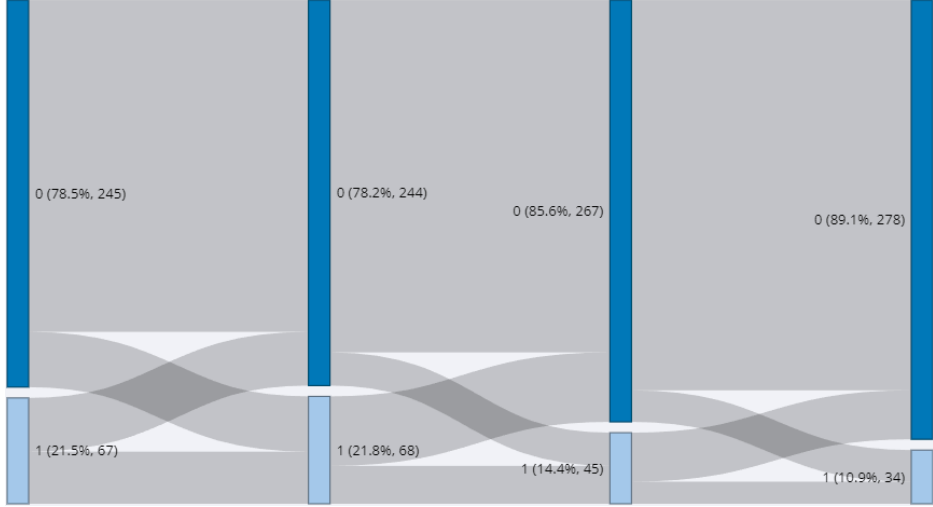
Figure 2. Year-by-year trajectory of a high-risk group for sleep problem (1 = high risk).